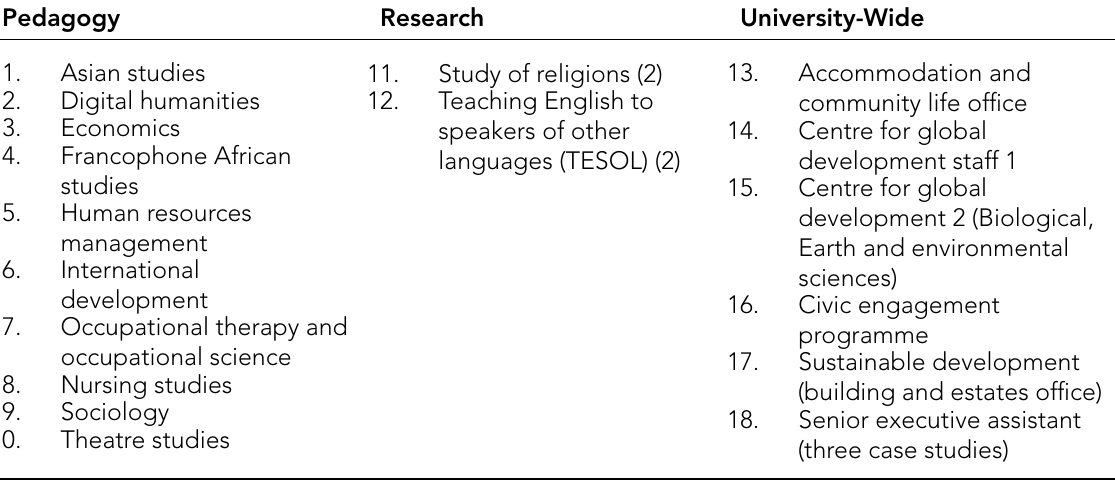
Table 1. UCC staff disciplines, departments and case study type (Source: Authors, 2022).